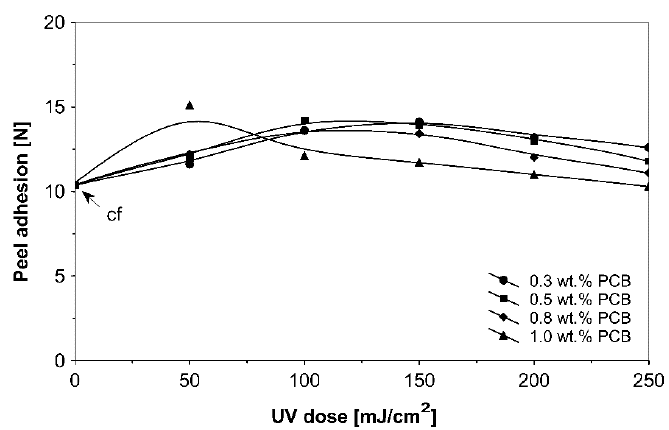
Figure 9. Peel adhesion of UV-crosslinked acrylic PSAs containing various amounts of additionable photoinitiator versus UV dose.